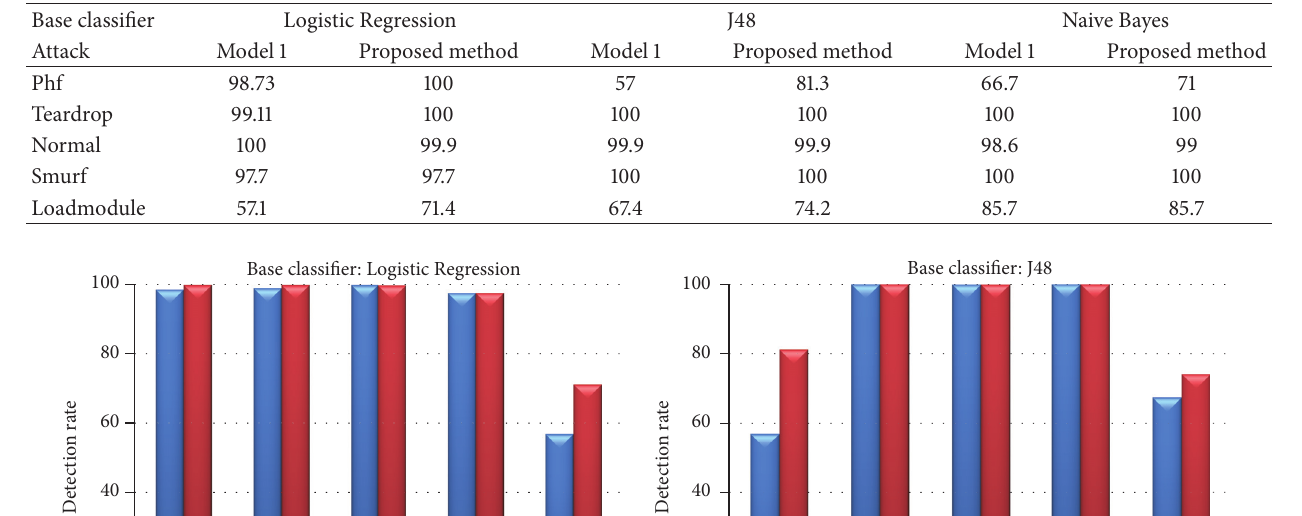
Table 2: Performance evaluation using detection rate (%).